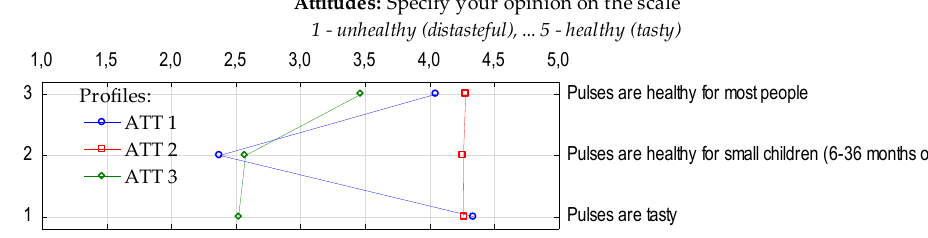
Figure 3. Profiles of respondents regarding attitudes towards health and taste of pulses.